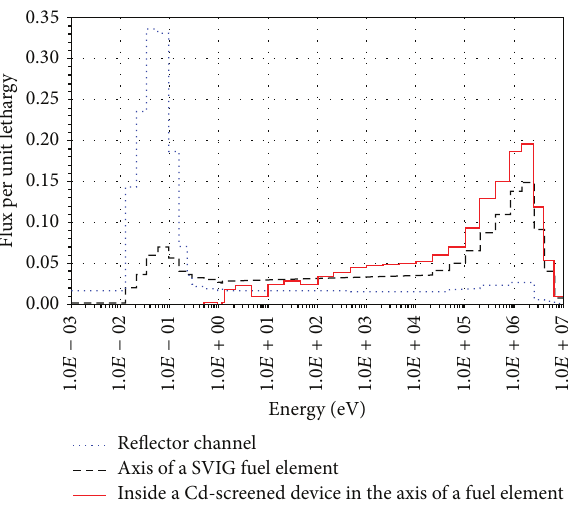
Figure 2: Neutron spectra in BR2